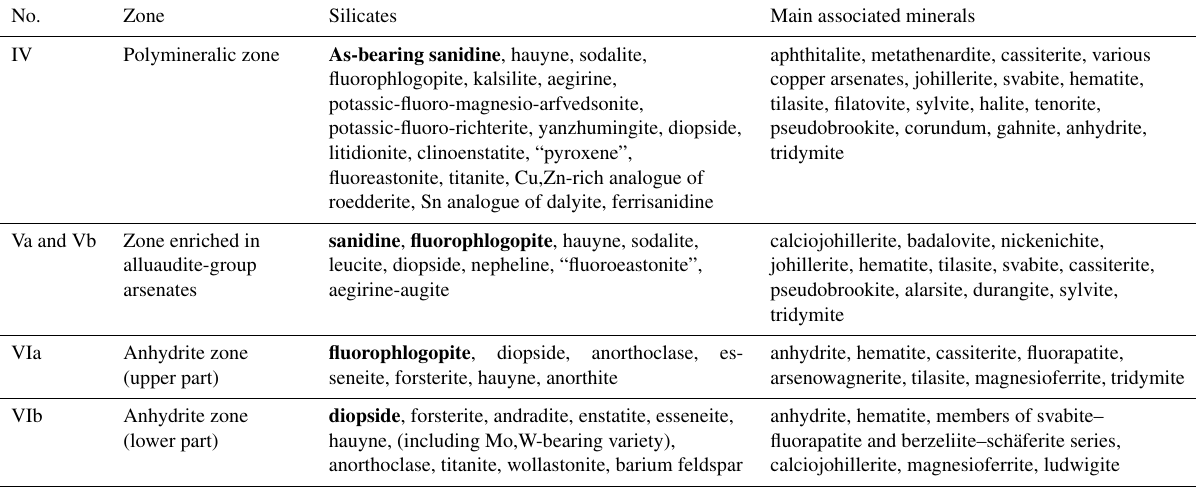
Table 2. Silicates (the most widespread species are marked in bold) and main associated minerals in different mineralized zones in the Arsenatnaya